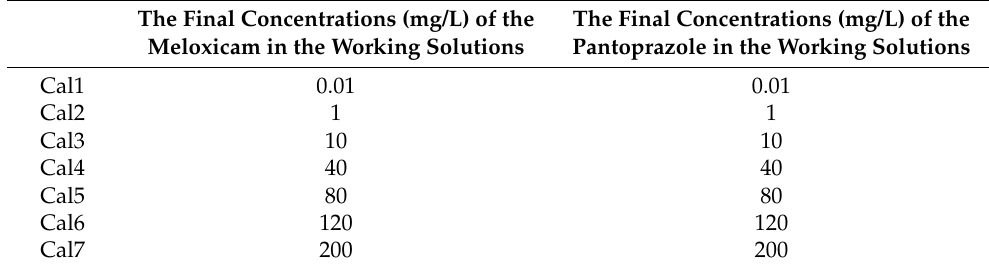
Table 1. Preparation of working solutions of meloxicam and pantoprazole (mg/L). The Final Concentrations (mg/L) of the The Final Concentrations (mg/L) of the Meloxicam in the Working Solutions Pantoprazole in the Working Solutions